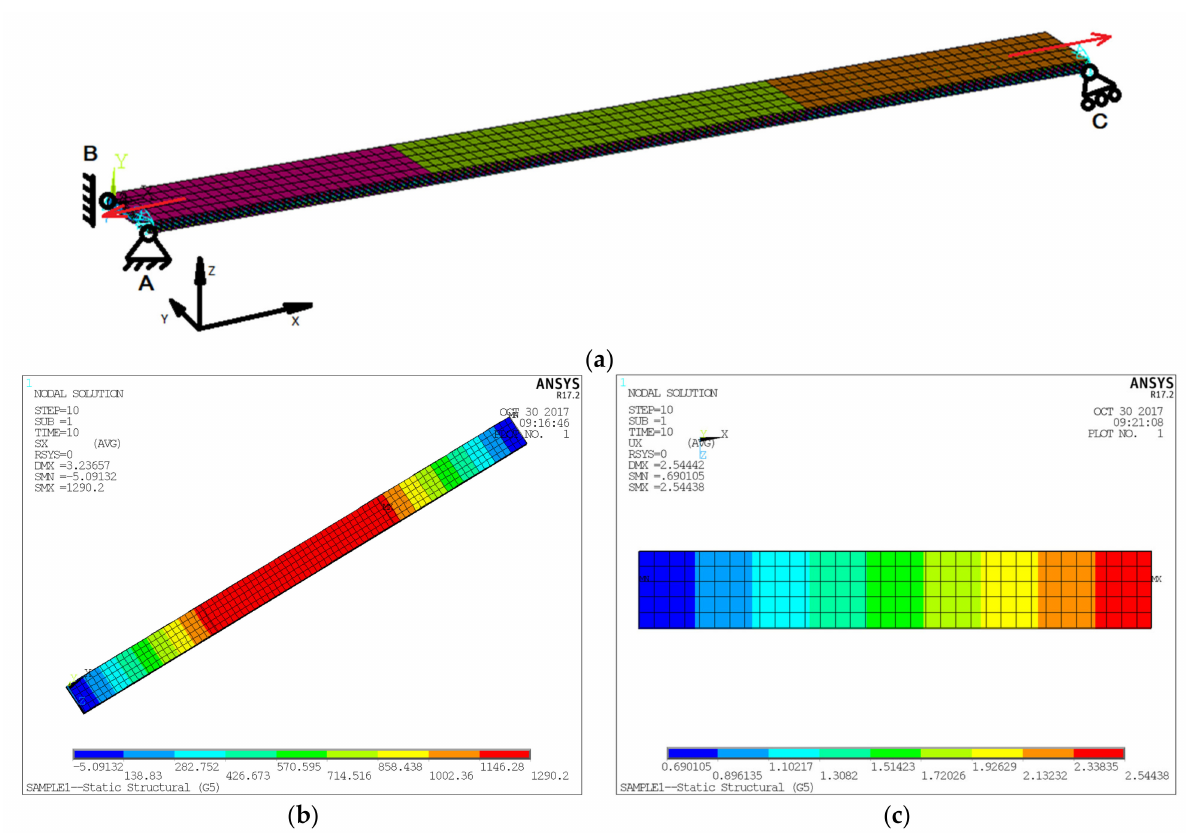
Figure 5. Example of boundary conditions ( a ), axial stresses ( b ) and axial displacements in the working area of the specimen ( c ) in the calculation of the specimen under tension and